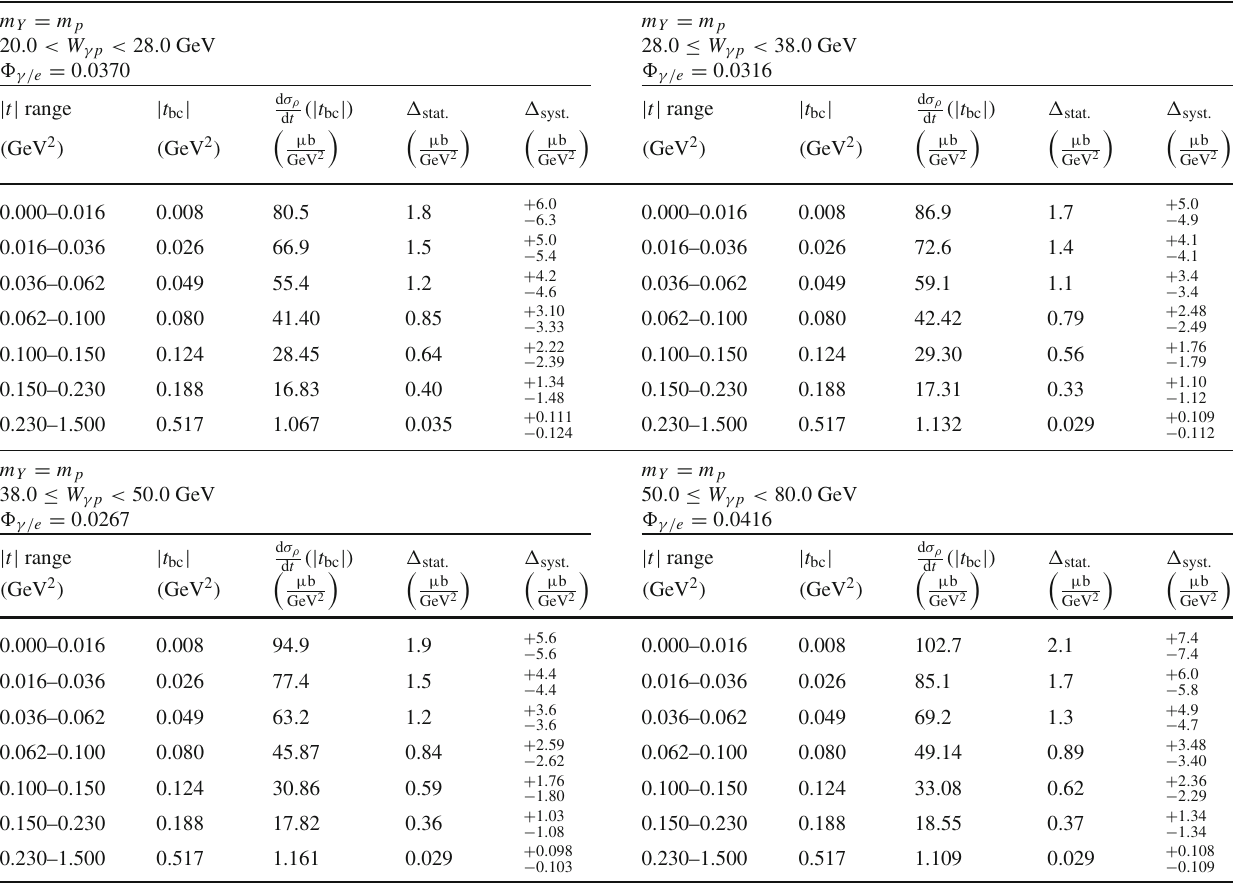
Table 12 Elastic ( m Y = m p ) differential ρ 0 meson photoproduction crosssectiond σ(γ p → ρ 0 Y )/ d t inbinsof W γ p and t .Thecrosssection isobtainedbyanalysingthe π + π − photoproductioncrosssectiongiven in Table 22 with the fit model defined in Eq. (18). The effective photon flux factors (cid:14) γ/ e for each W γ p bin are given. The t bin centres t bc are